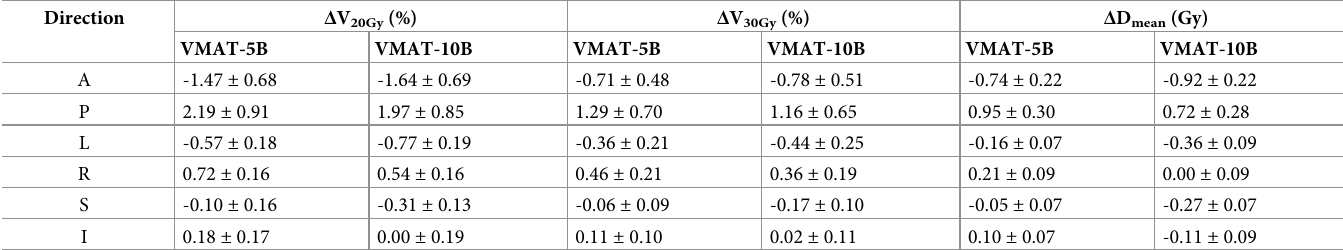
Table 4. Absolute differences in the heart between the perturbed and the original plans.